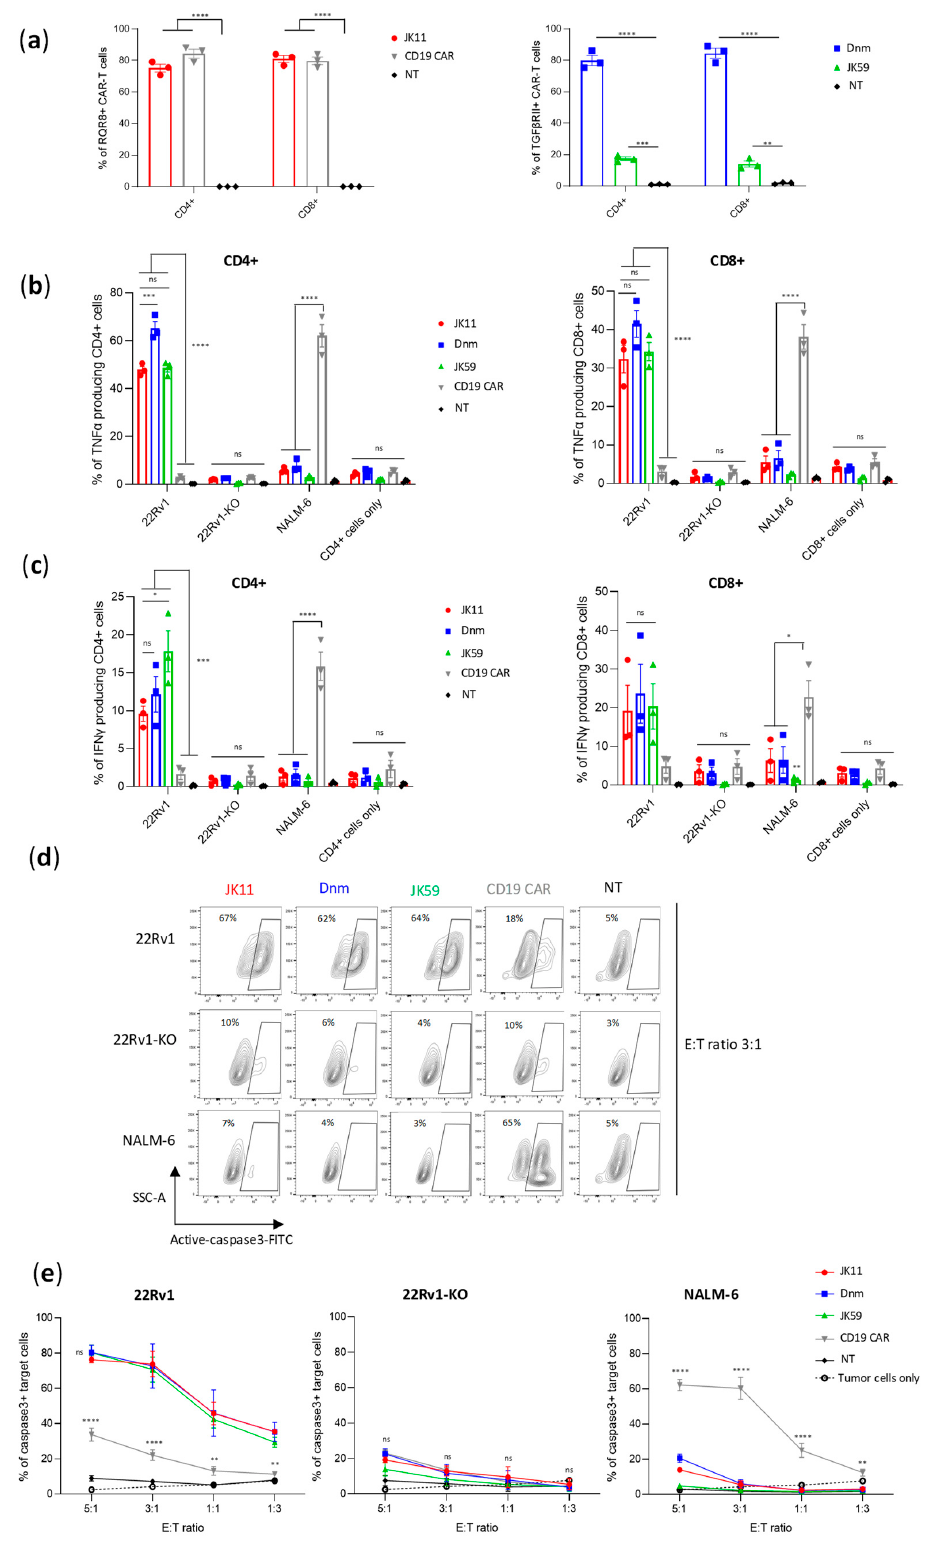
Figure 2. Dnm and SwR-STEAP1 CAR T cells induce the production of IFN γ and TNF α and apoptosis upon co-culture with STEAP1 + target cells in vitro. ( a ) Graphs of the CAR expression (measured five days after transduction) of freshly transduced JK11, Dnm, JK59, and CD19 CAR T cells and non-transduced (NT) T cells. The CAR expression of JK11 and CD19 CAR T cells (left panel) was detected with the antibody recognizing the RQR8 sequence, and the CAR expression of Dnm